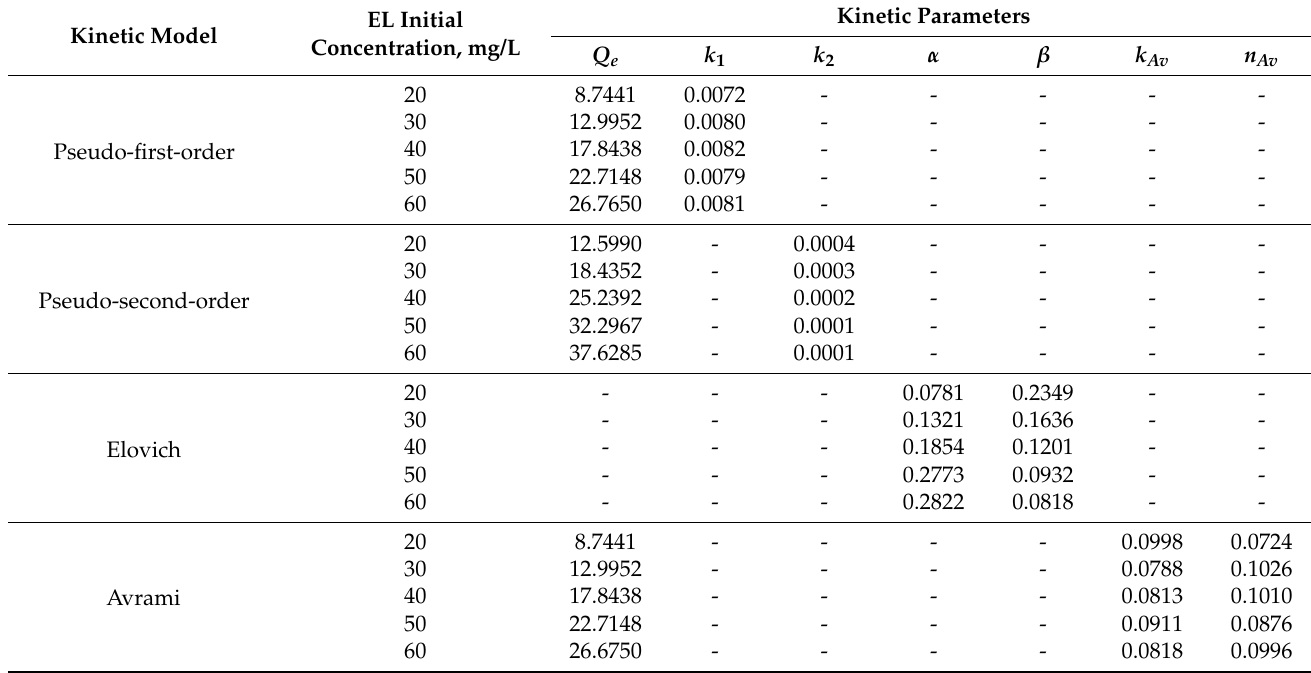
Table 4. Kinetic parameters of the biosorption process conducted on SPA 5% biosorbent.